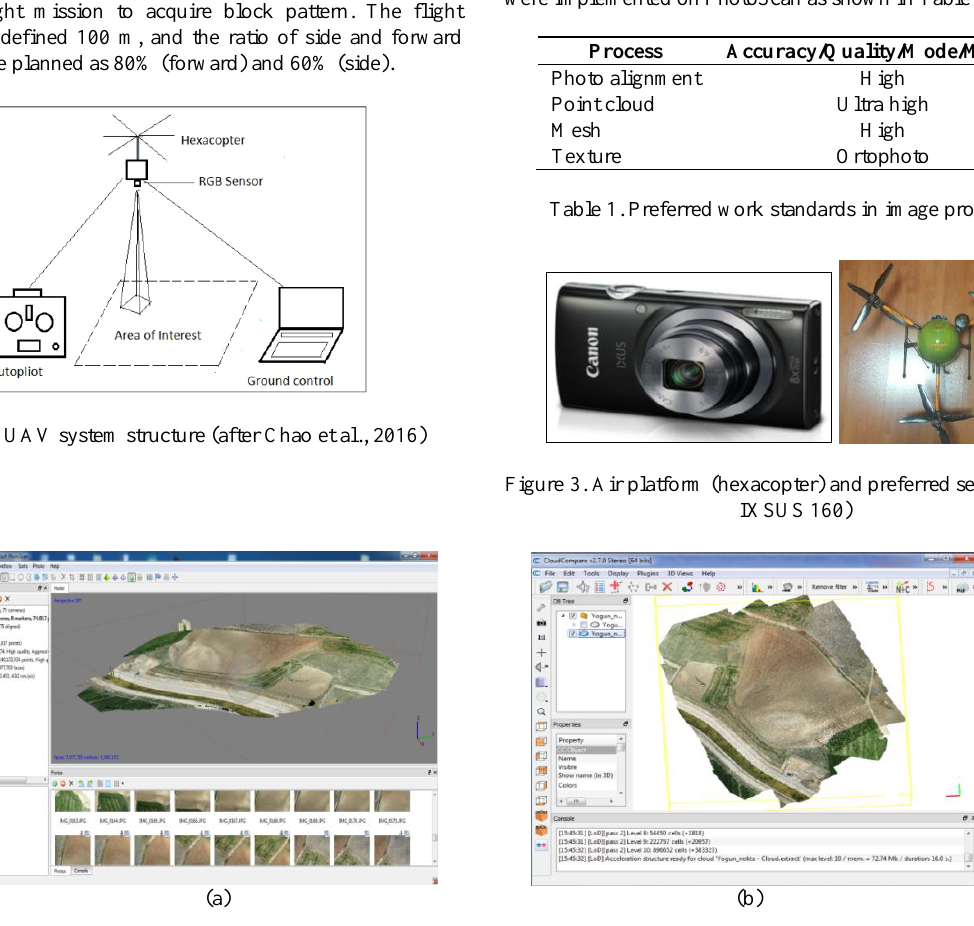
Figure 4. Interface views of software used in image processing. (a) Agisoft PhotoScan, (b) CloudCompare